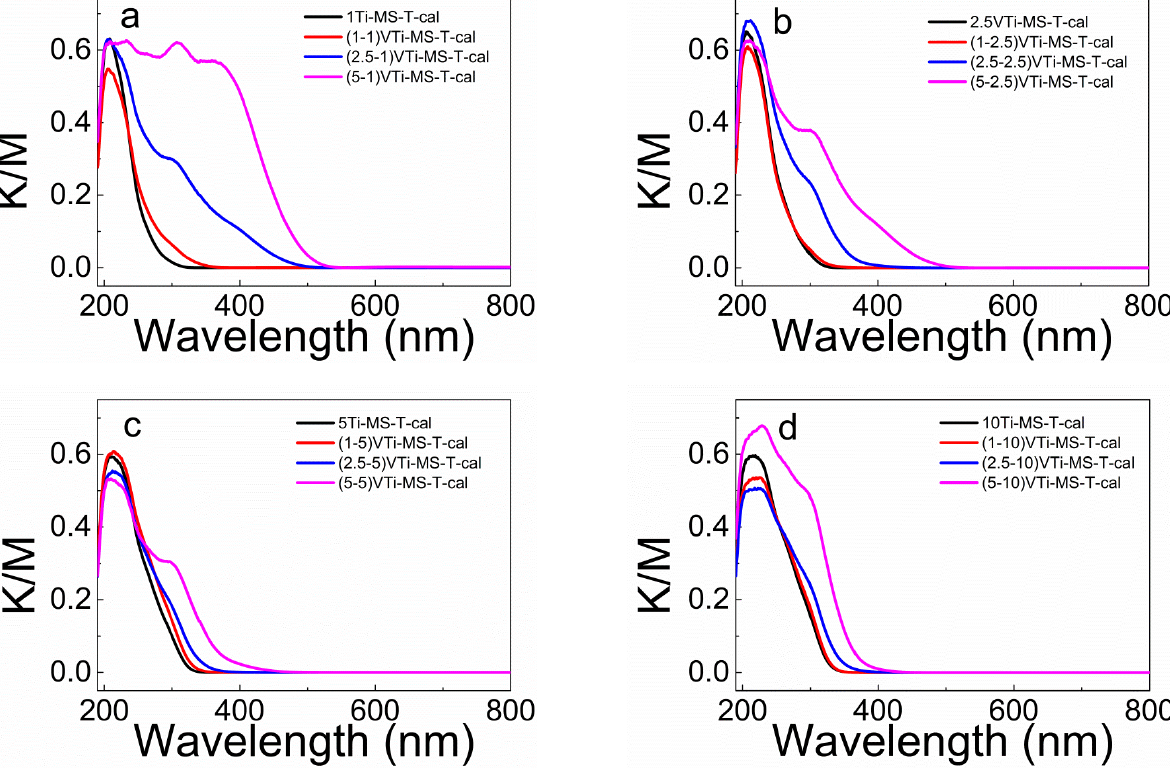
Figure 2. UV–vis spectra of VTi-MS-T-cal samples containing 1 ( a ), 2.5 ( b ), 5 ( c ) and 10% ( d ) Ti anchors; MS-L-cal was used as blank, and before measurement, samples were diluted in MS-L-cal to keep the spectra intensity in the range of 0.2 to 0.8 K/M. K/M: Kubelka–Munk function (SI).